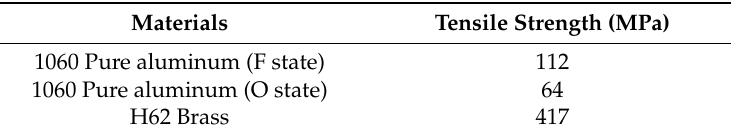
Table 3. Tensile strength of base material.